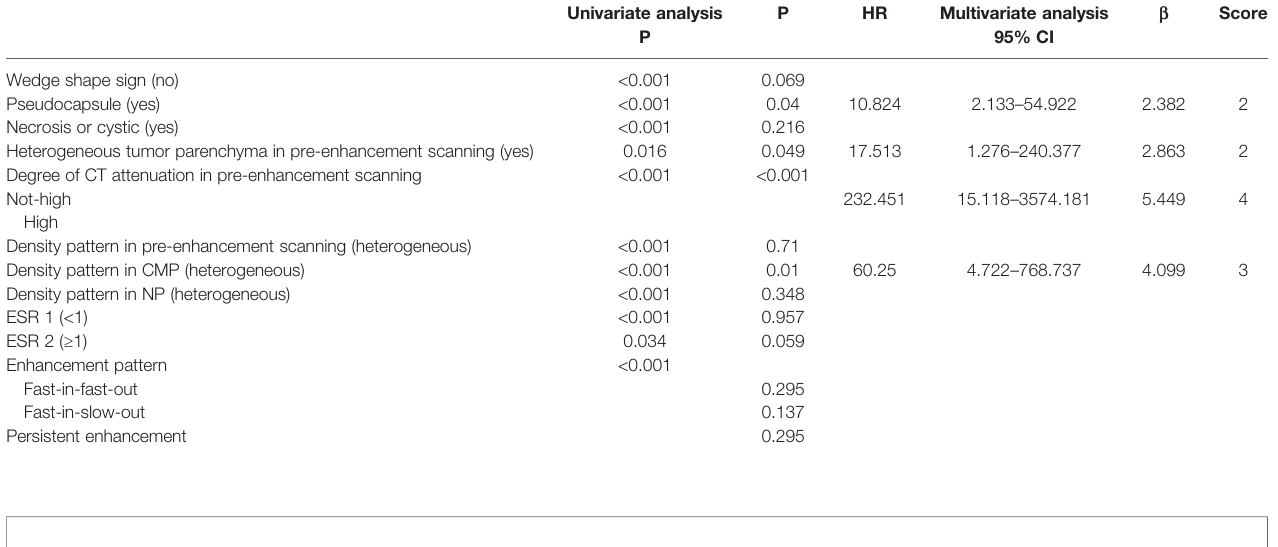
Univariate analysis